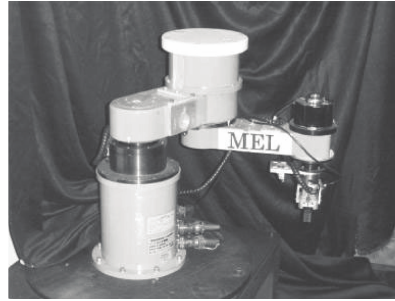
Figure 6: High-performance robot used as